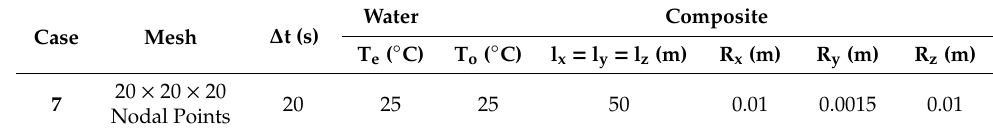
Table 3. Parameters used in the simulation for the three-dimensional (3D) case.